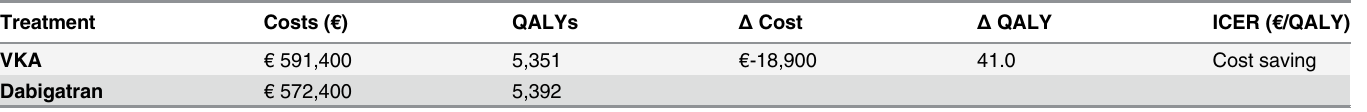
Table 3. Incremental costs, QALYs and ICER for patients with DVT receiving 180 days anticoagulation therapy from the societal perspective (base case analysis) for a cohort of 1000 patients.